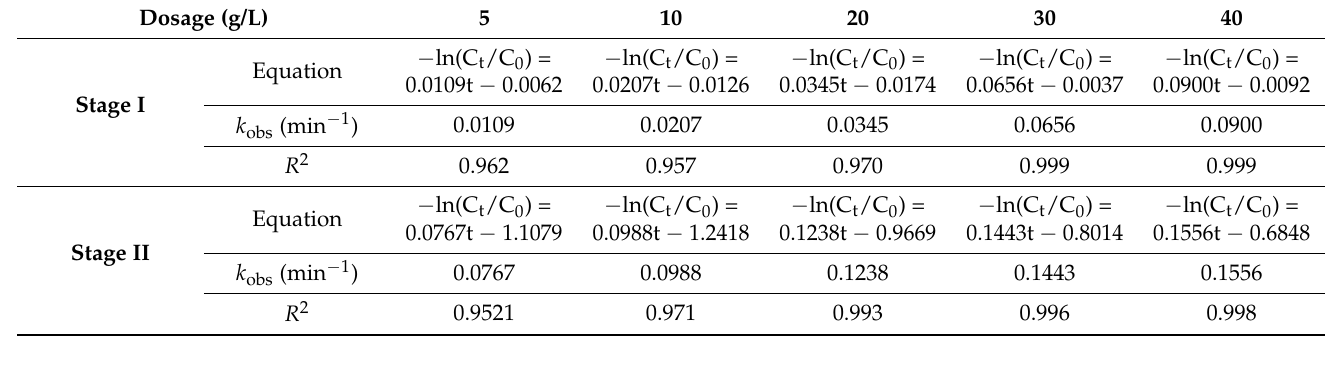
Table 3. Rate constants for CCl 4 degradation with 0.4 wt.% Ag/Fe at different dosages.